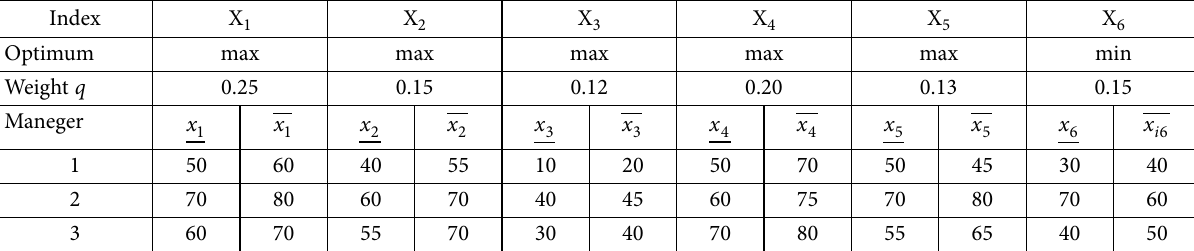
Table 4. Initial decision-making index with the criterion values described in intervals and normalized weighted matrix